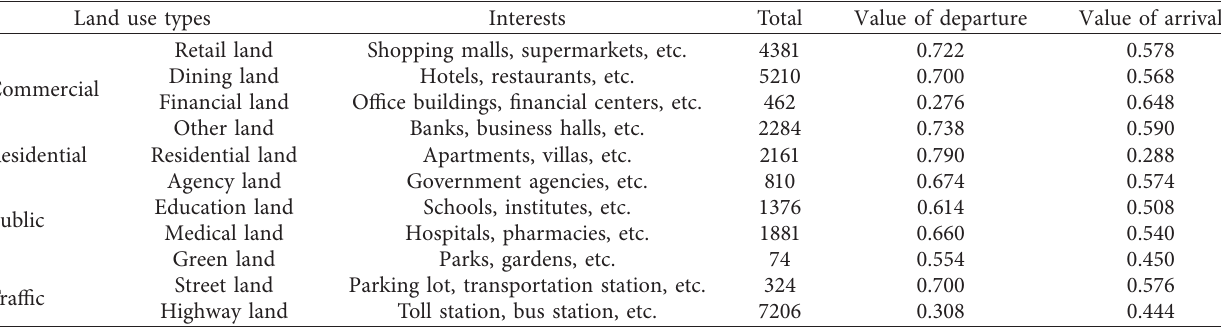
Table 2: Activities at different points of interests.